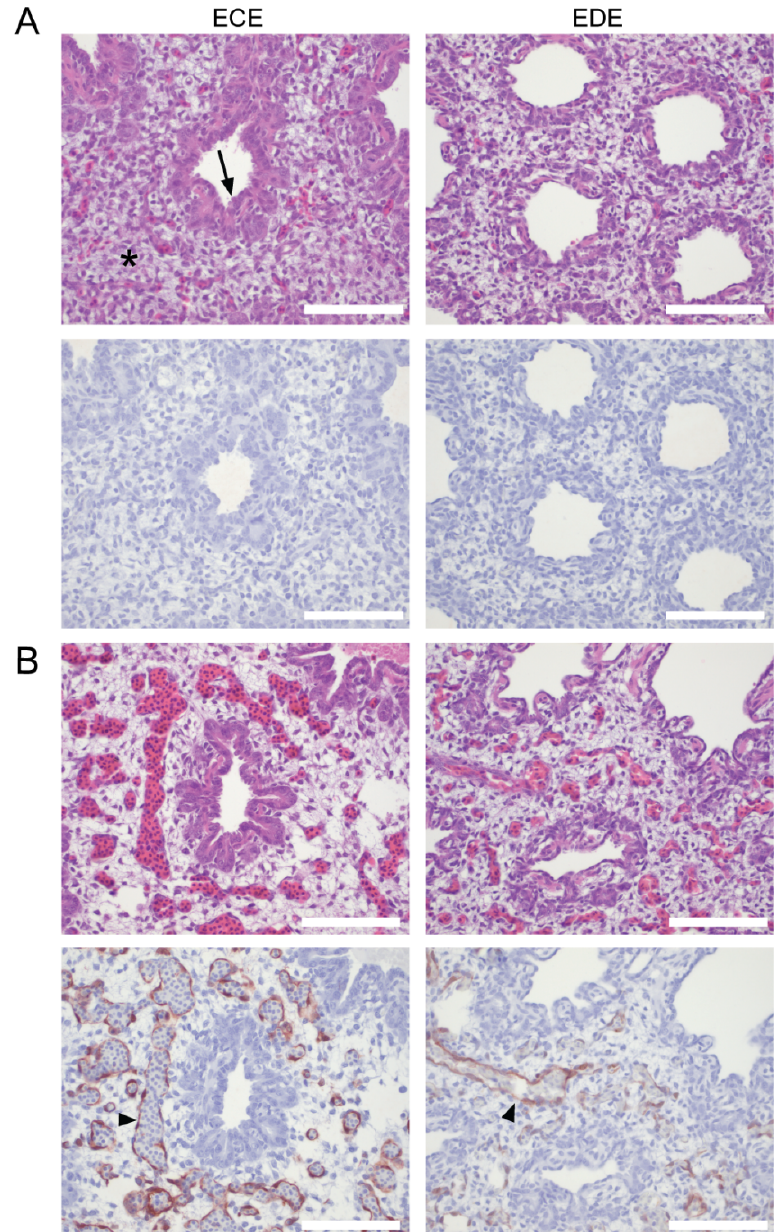
Figure 5. Cell tropism of H5N1 HPAIV in lungs of chicken and duck embryonated eggs. Fourteen- day-old ECE and 18-day-old EDE were mock-inoculated with PBS ( A ) or inoculated with 10 3 TCID 50 RG-A/turkey/Turkey/1/05 H5N1 ( B ) via the allantoic route (two embryos per condition). Embryos were harvested at 24 hpi and processed for immunohistochemistry. Top panels show HE staining. Bottom panels show influenza A virus NP staining as indicated by a red precipitate. Representative images of the lungs are shown. The mesenchyme (asterisk), epithelial cells from the premature parabronchi (arrow), and NP-positive endothelial cells (arrow head) are indicated. The scale bar represents 100 µm.